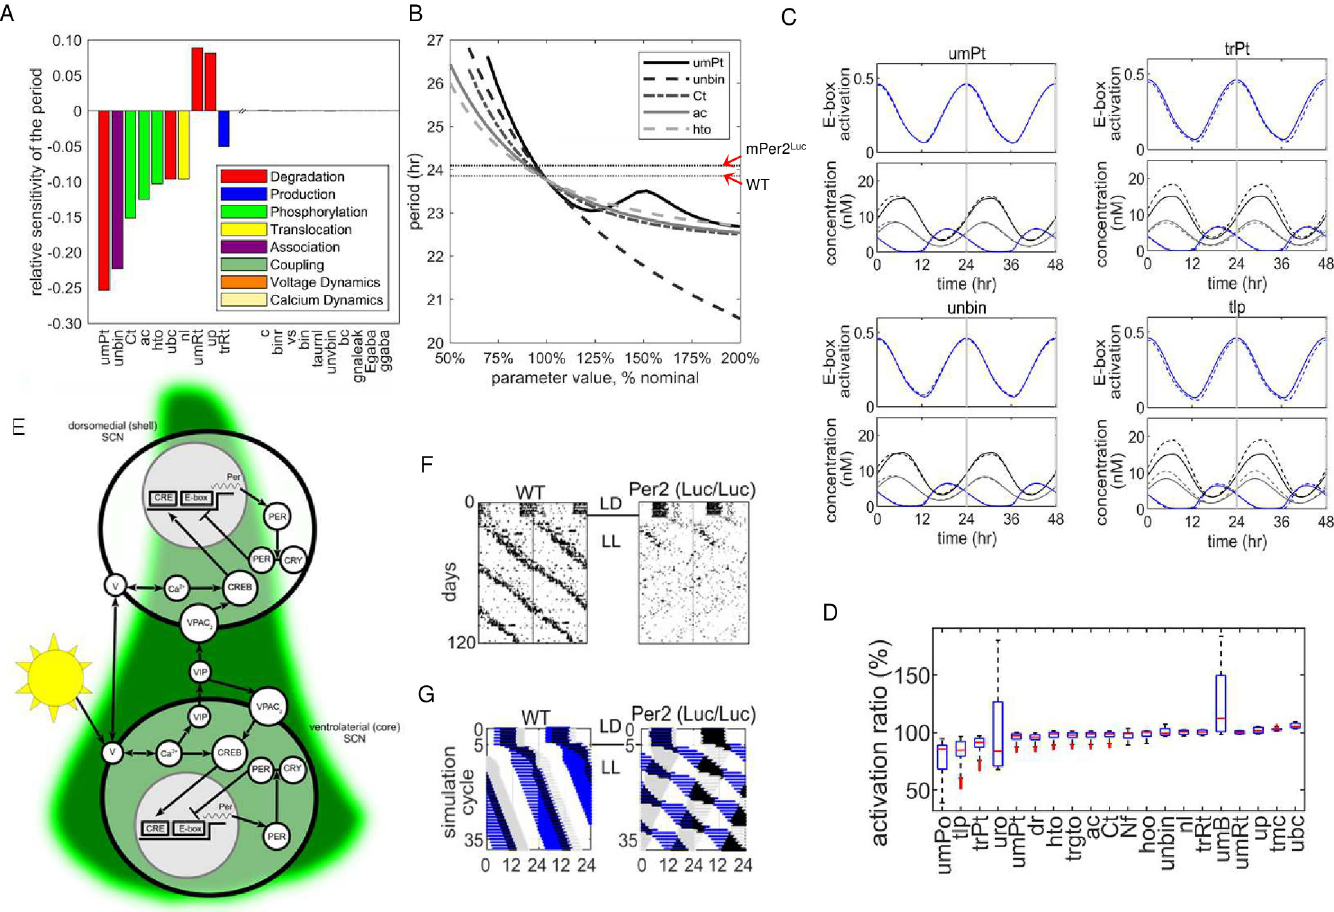
Fig 7. Extended mathematical model of SCN rhythm production. A . Parameter sensitivity analysis for single pacemaker cell period. Histograms represent the percent change for each parameter required to alter period in DD from WT to mPer2 Luc/Luc . B. Sensitivity of period to the top 5 parameters. The model’s nominal base period is set at 23.8h for WT and 24.3 for mPer2 Luc/Luc as indicated by the two horizontal lines. C. Circadian patterns of dependent variables represented by changes in E- box occupation/activation and total concentrations of PER1, PER2, BMAL/CLOCK as a result of changing four parameters ( umPt , unbin , trPt , uro ) to obtain the mutant period. Solid lines = WT model. Dashed lines = mPer Luc model. Time courses are normalized so that maximum E-box activation occurs at time = 0. Additional simulations are contained in S2A–S2H Fig . D. Comparison of E-box activation for simulations of WT and mPER2 Luc rhythms. The box and whisker plots show the distribution over one cycle: red lines are medians; blue boxes are first-to-third quartiles; black lines are extrema; and red dots are outliers. 100% = no difference between genotypes. E. Functional anatomy of the SCN pacemaker. The model is based on a primary transcription-translation feedback loop in all cells. The dynamics of the membrane potential V is coupled to the molecular clock through cytosolic calcium. The single cell model of the molecular clock is used for both the dorsal and ventral SCN regions. The regional difference is produced by the light input, and inter-regional communication is via VIP driving PER transcription through VPAC 2 and the cAMP response element (CRE). VIP is produced and released from cells in the ventral SCN onto both shell and core cells. F. Representative actograms from WT and Per2 Luc mice housed in LL. G. Simulations using the two oscillator SCN model in LL with baseline parameters (left) and adjustment of Per2 mRNA stability ( umPt ) to represent the presence of Per2 Luc . Parameter symbols : umPt : degradation rate of Per2 RNA; unbin : normalized unbinding rate for BMAL1-CLOCK/NPAS2 to Per1/2/ Cry1 E-box; ac : binding rate for PER1/2 to CK1 ε / δ ; Ct : total Ck1 concentration; hto : CK1 ε / δ phosphorylation rate for PER2; ubc : degradation rate for BMAL1-CLOCK/ NPAS2; nl : nuclear localization rate for proteins bound to PER; trPt : transcription rate for Per2 ; mRt : degradation rate for Cry2 ; up : degradation rate for CK1 phosphorylated PER; vs : production rate of cAMP when VPAC2R bound by VIP; dg : unbinding rate for PER2/REV-ERBs to GSK-3 β ; cvbin : binding rate of CRY1/2 to VPAC2R; uro : degradation rate constant for